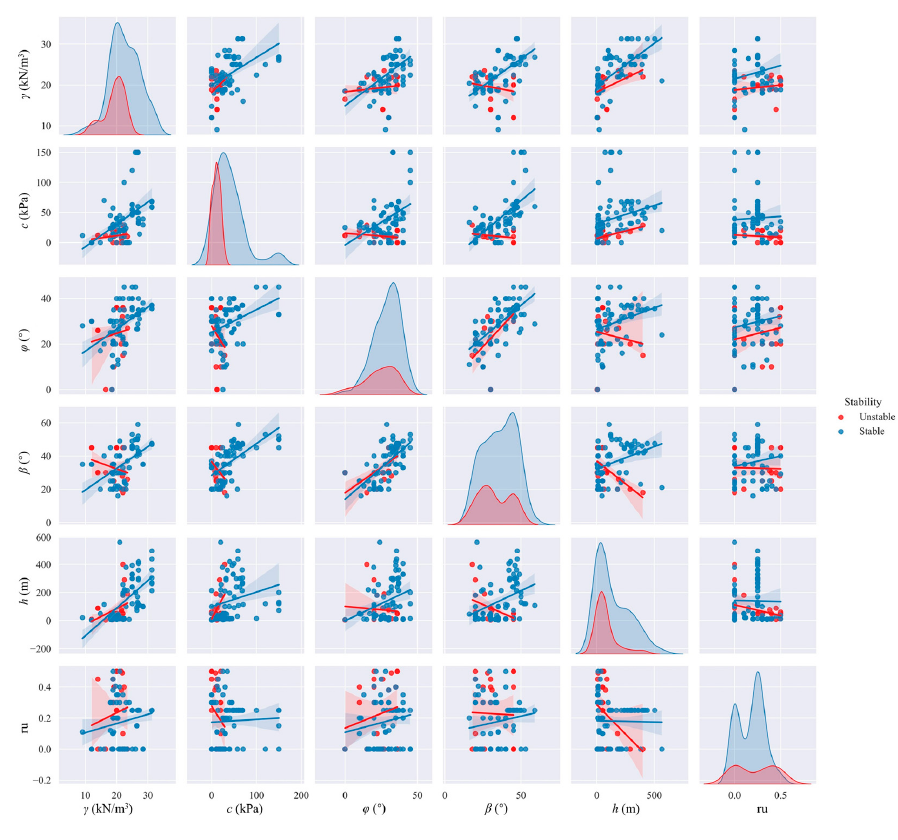
Figure 2. Correlation analysis of the parameters.